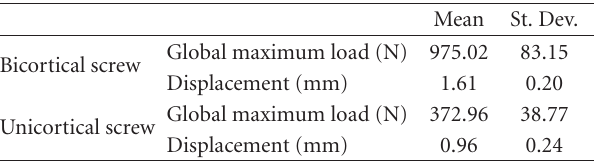
Table 4: Load and displacement results for the screw pull-out